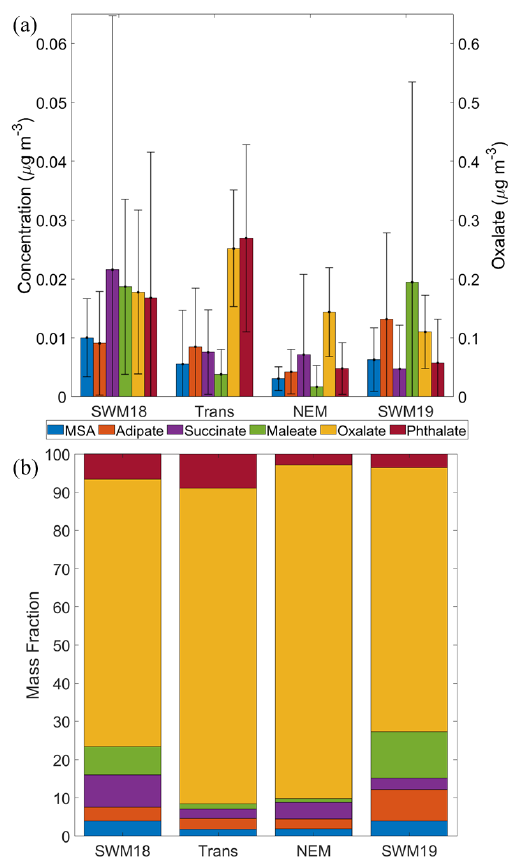
Figure 3. (a) Average concentrations (0.056–18µm) for (left y axis) MSA, adipate, succinate, maleate, and phthalate, in addition to (right y axis) oxalate. Black bars represent 1 standard deviation. (b) Percentage relative mass abundance of organic acids and MSA separated based on